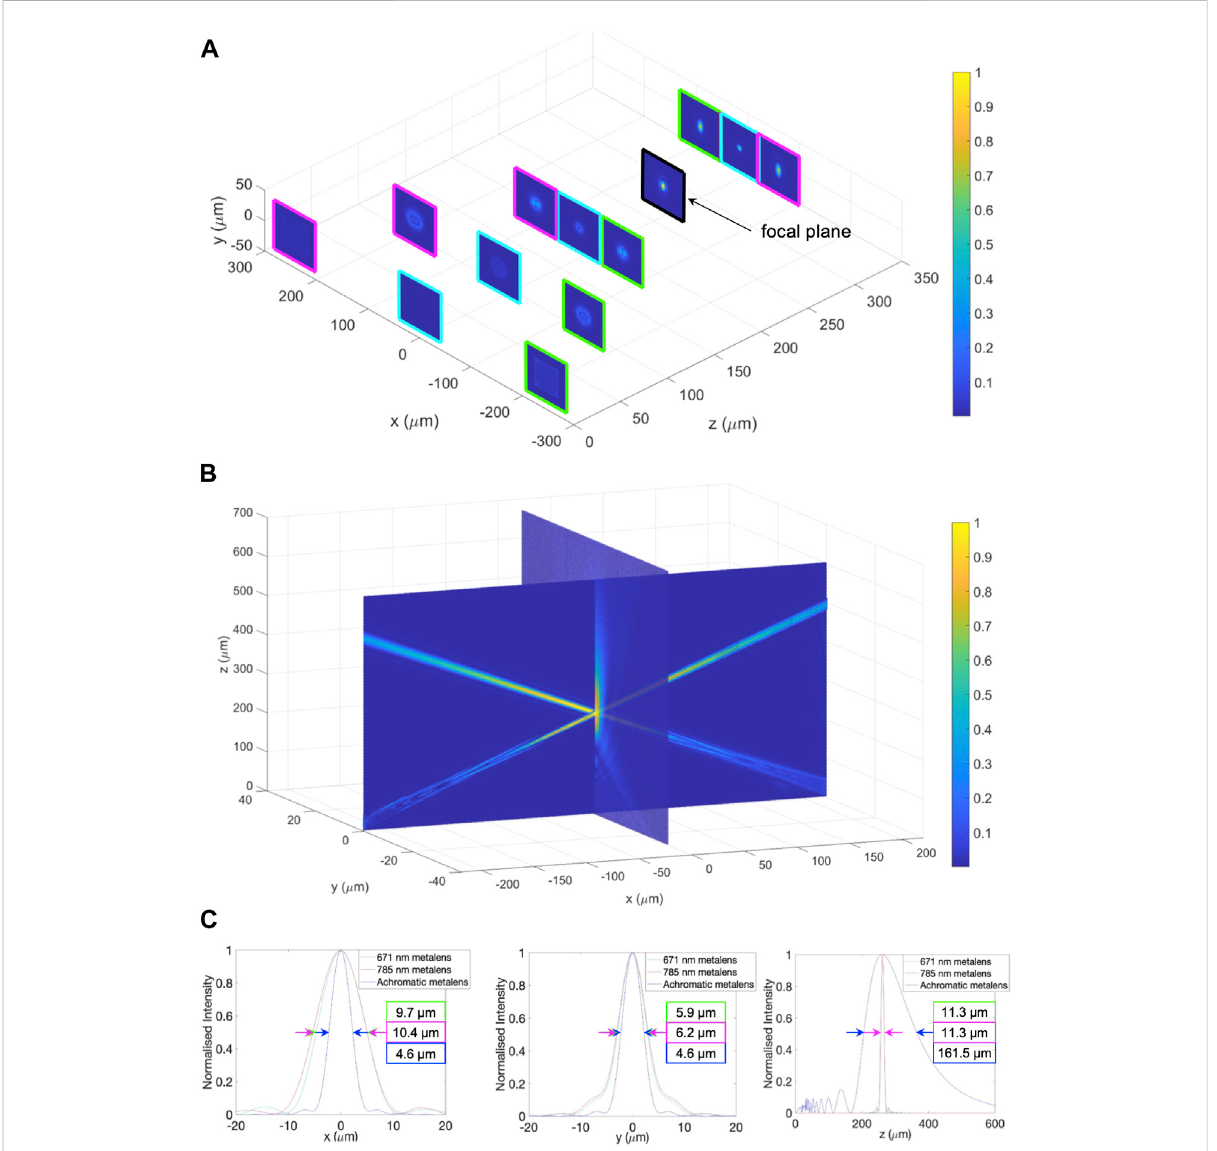
FIGURE 7 Focal point pro fi les of all metalenses. (A) 3D beam propagations of all three metalenses - magenta: 785 nm hybrid off-axis metalens, blue: 810 – 910 nm achromatic on-axis metalens, green: 671 nm hybrid off-axis metalens. The focal plane is shown in black. (B) Perspective view of the overlapping region of all three metalenses. (C) Normalized intensity plots of focal points along the x, y, and z-axis, showing the measurements of focal points in each